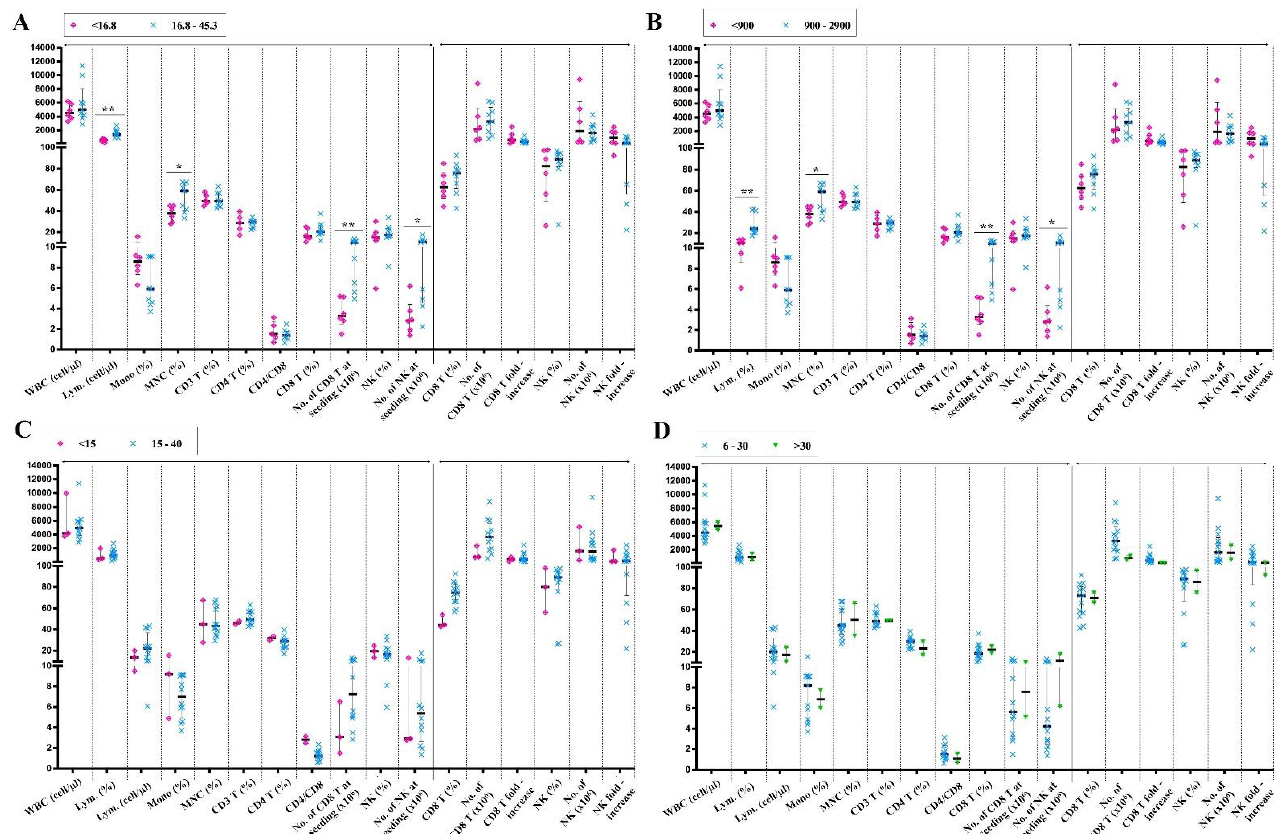
Figure 4 . The comparison of immune cell expansion capacity between subjects with a normal and abnormal frequency of PB-lymphocytes ( A ), the density of PB-lymphocytes ( B ), the frequency of PB-CD8 + T cells ( C ), and the frequency of PB-NK cells ( D ). Significant differences were obtained by the Wilcoxon signed-rank test followed by the Bonferroni correction. Median values and interquartile ranges are plotted in graphs. Significance levels were set to p < 0.05 (*), and p < 0.01 (**). PB: Peripheral blood; WBC: whole blood cell count; SL: number of; Lym.: Lymphocytes; MONO.: Monocytes; MNC: mononuclear cells.